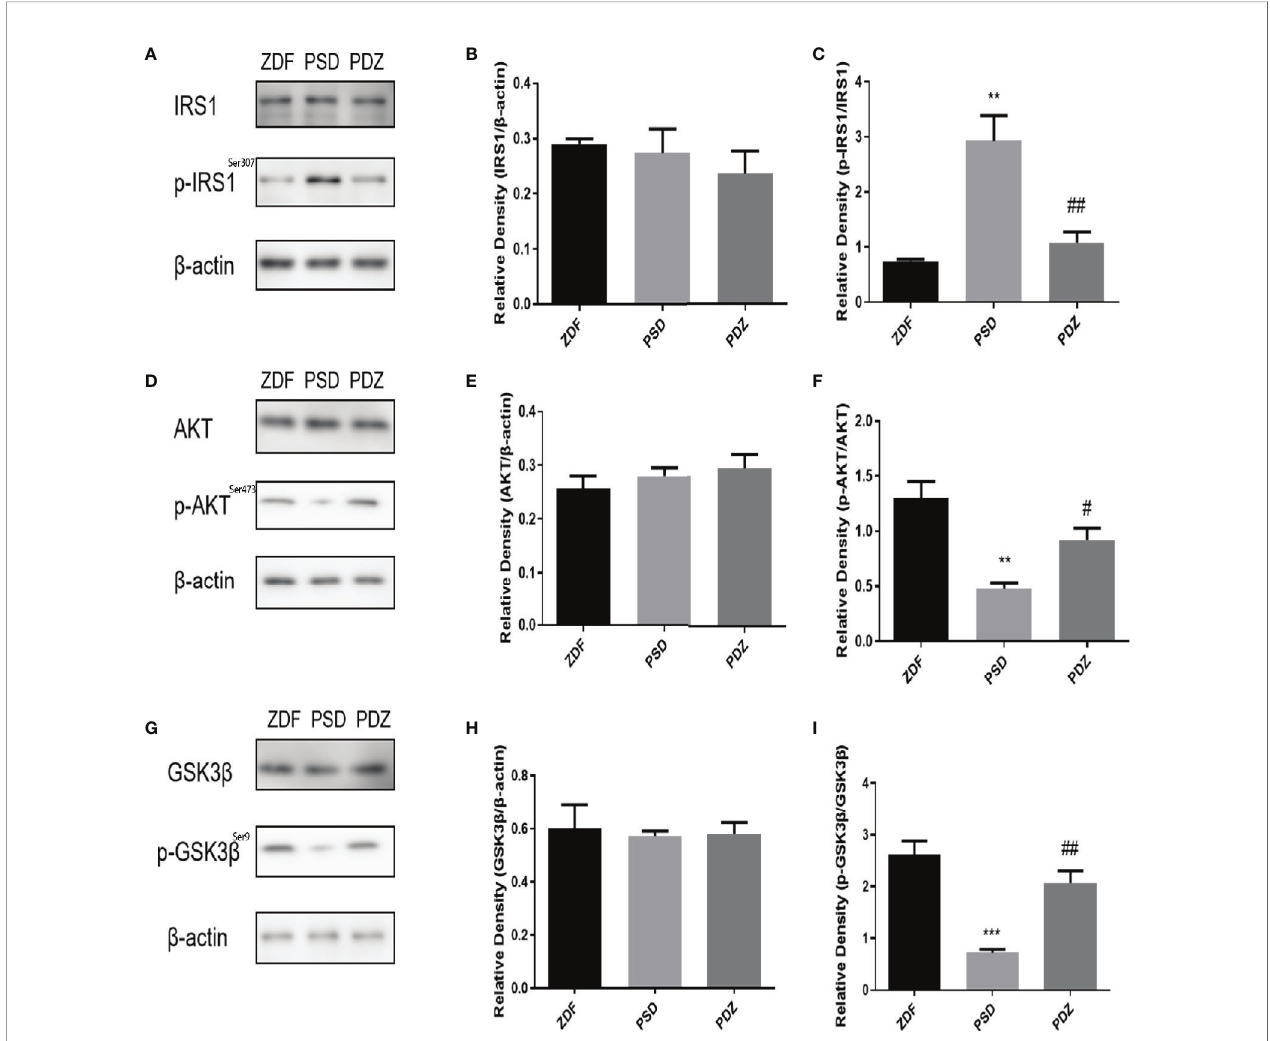
FIGURE 7 | Effect of ZBPYR on cerebral insulin signaling and GSK3 b in the mPFC of ZDF rats. Protein expression of IRS1 and p-IRS1 in the mPFC of each group (A – C) . Protein expression of AKT and p-AKT in the mPFC of each group (D – F) . Protein expression of GSK3 b and p-GSK3 b in the mPFC of each group (G – I) . Bars represent the mean ± SEM. ** P < 0.01, *** P < 0.001, PSD group vs. ZDF group; # P < 0.05, ## P < 0.01, PDZ group vs. PSD